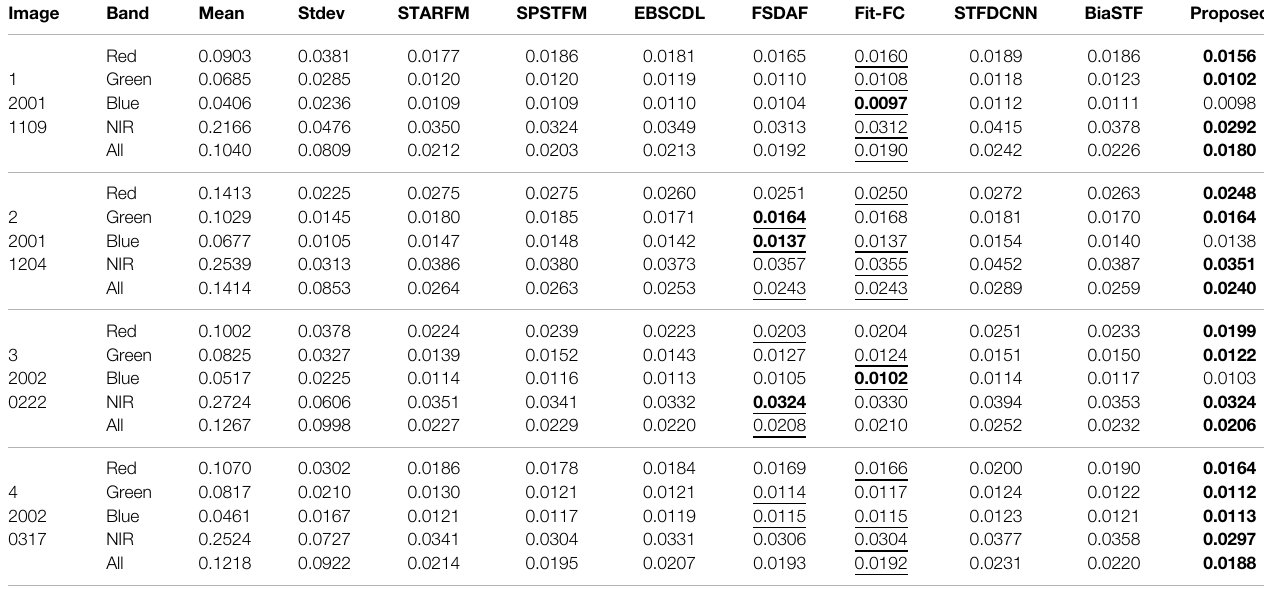
TABLE 1 | RMSE evaluation of radiometric error for the CIA dataset. Image BiaSTF